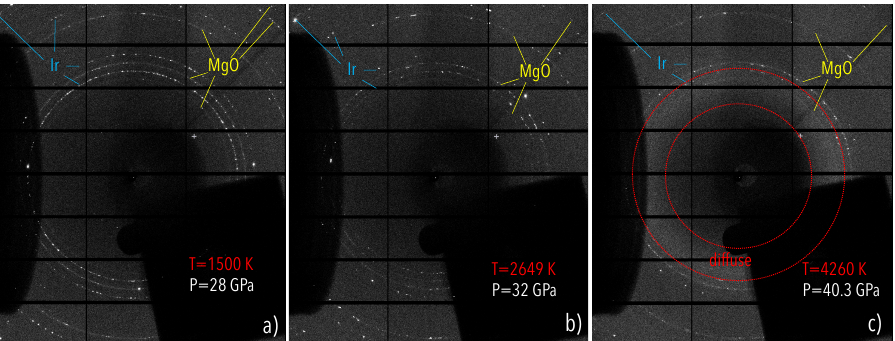
Figure 4. Textural evolution of Ir sample and MgO-insulating material during the heating ramp where melting was observed. ( a ) Both the sample and MgO are showing T -effects, characterized by the presence of smaller (more intense) spots withing the powder rings. ( b ) While the MgO texture remains quite similar to the previous case, Ir now exhibits the presence of single crystals caused by the growth of Ir grains [18]. ( c ) Ir crystal peaks have essentially disappeared and have now converted into an amorphous halo, whilst the XRD signal from the MgO is still similar to the previous case. In all the reported images, the peaks belonging to Ir and MgO are labelled and the corresponding P – T conditions indicated. In ( c ), the concentric red circles are used to assist the reader in identifying the presence of the diffuse halo. The shadows observed on each image are caused by the presence of the various optics of the LH system of I15